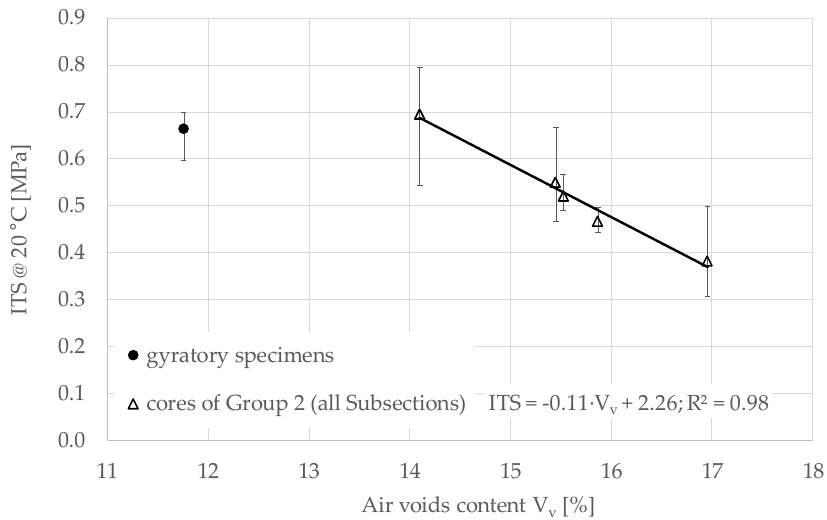
Figure 12. Indirect tensile strength (ITS) (with max and min error bars) as a function of air voids, 157 days after construction.